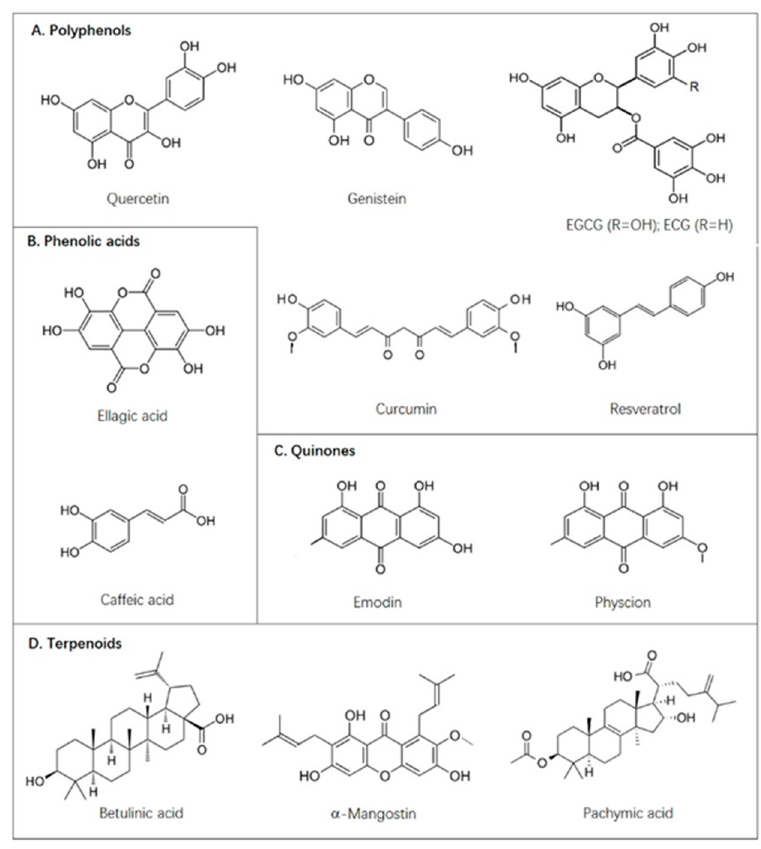
Figure 2. Naturally occurring compounds discussed in this paper.